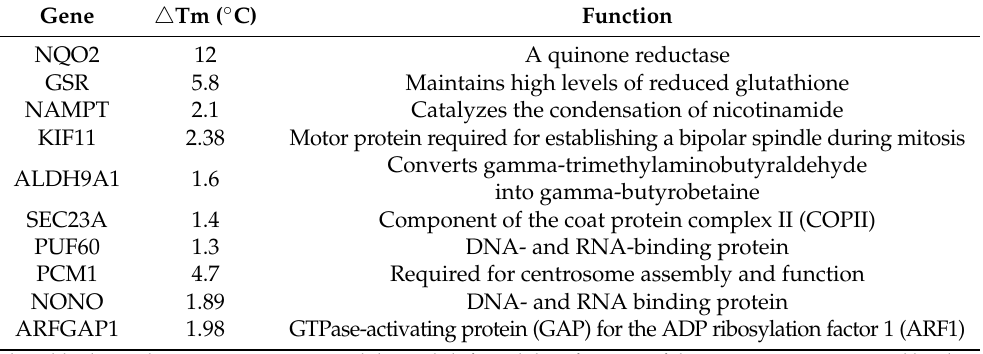
Table 1. The representative potential binding proteins of HCQ.